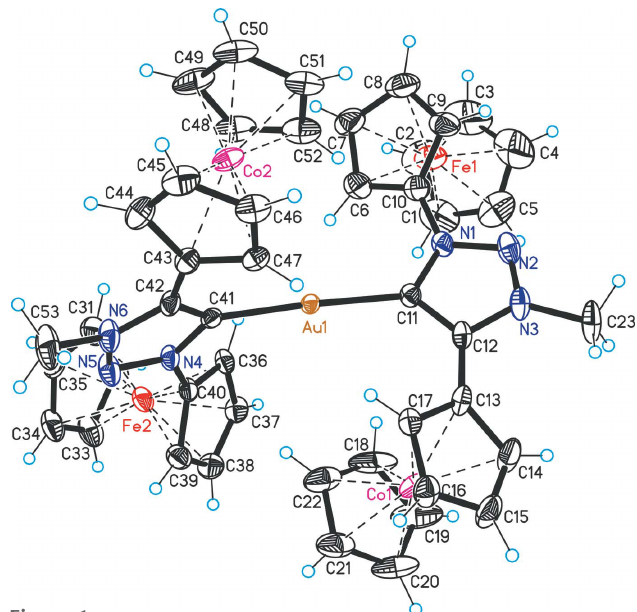
Figure 1 The structure of the title compound, with displacement ellipsoids drawn at the 30% probability level for non-H atoms (the disordered counter- ions were omitted for clarity).